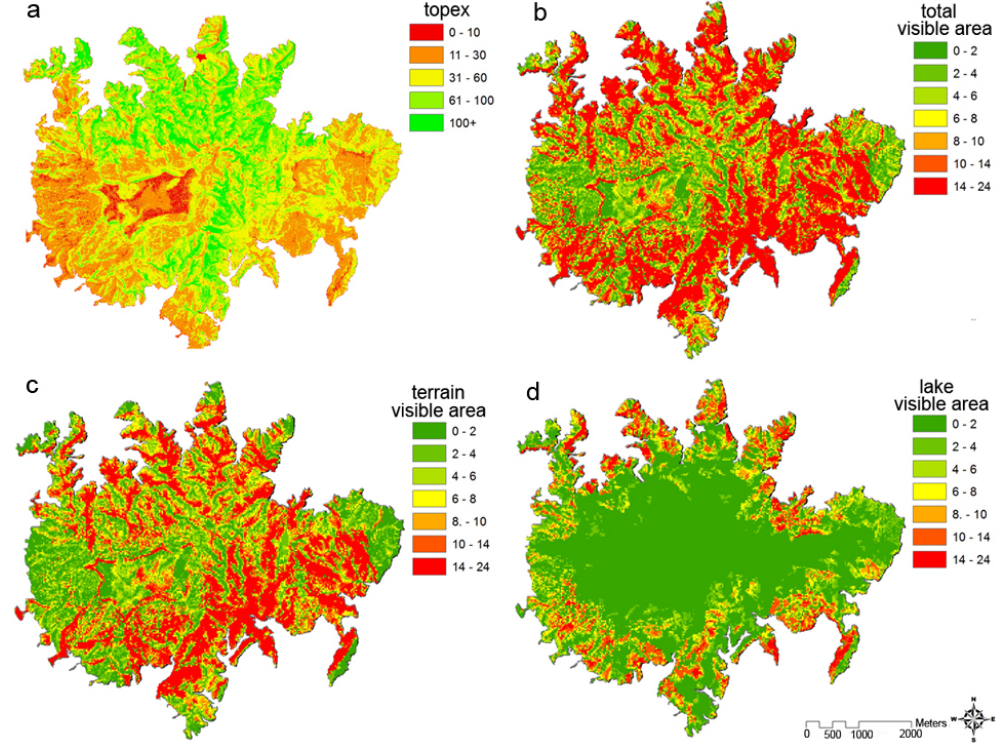
Fig. 2. Spatial distribution of different measures of topographic exposure to wind of the forest across Barro Colorado Island (BCI); these include: (a) topex, (b) total visible area, (c) terrain visible area and (d) lake visible area.